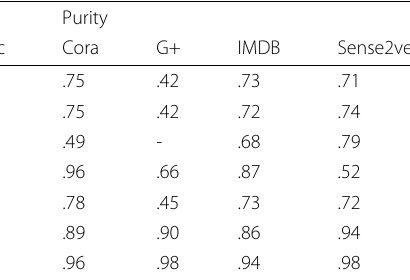
Table 1 Single-nominal: comparison of modularity and purity scores. S AC 1 was not able to terminate on the G+ in reasonable time due to its high computational complexity Modularity Purity Cora G+ IMDB Sense2vec Cora L